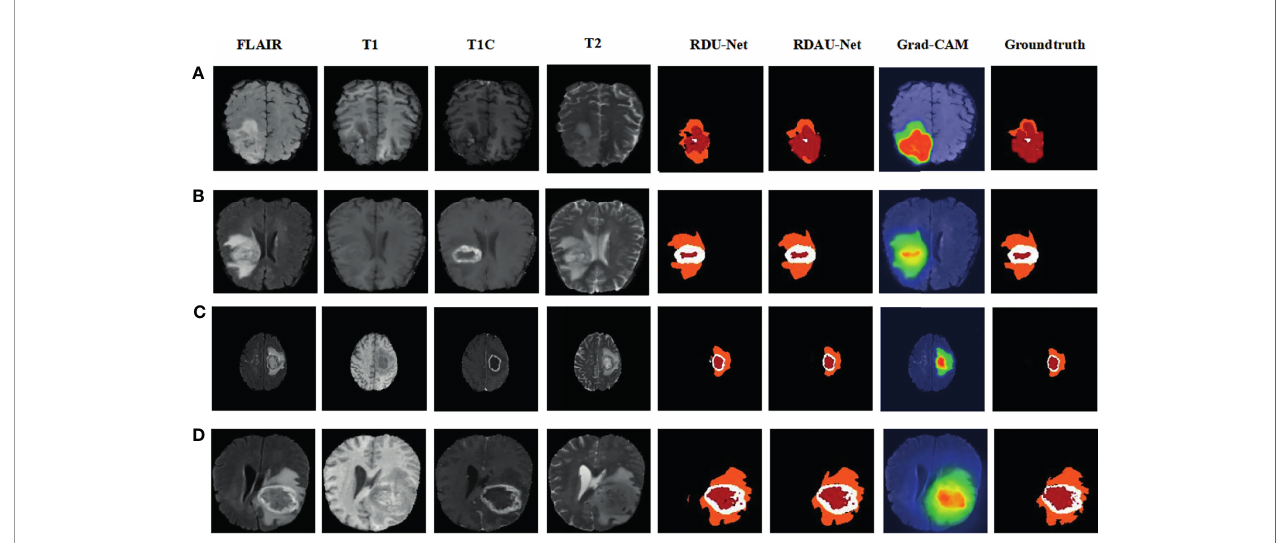
FIGURE 7 | Segmentation results of the proposed method and RDU-Net (without attention) on the BRATS 2018 datasets, the Grad-CAM result and the ground truths. Rows (A – D) : Brats18_TCIA01_387_1_93, Brats18_TCIA01_231_1_83, Brats18_CBICA_APR_1_105, Brats18_CBICA_AUN_1_81, where 105, 101, 78, and 73 represent the 105th, 101st, 78th, 73rd slices, respectively, of the MRI data. The colors represent the following categories: edema, necrosis, and □ enhancing core.